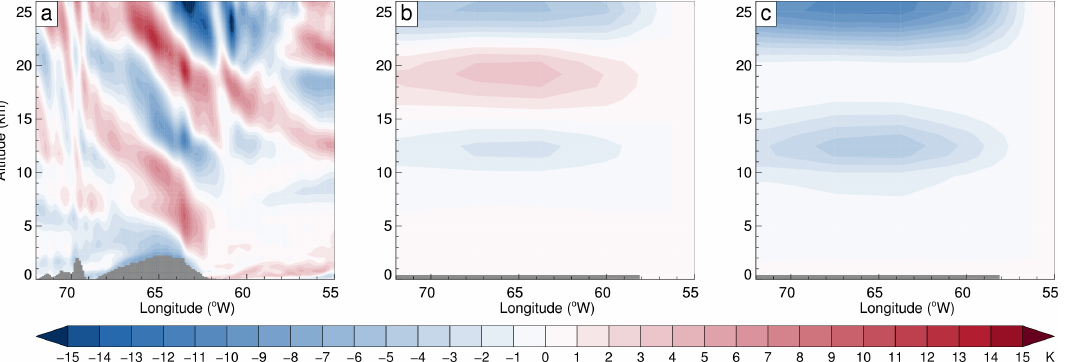
Figure 6. Vertical cross section intersecting the AP along a latitude band at 70 ◦ S of the temperature fluctuations (K) simulated by the mesoscale model (a) and parameterised by the mountain wave scheme (b) at the time of the CS3 mountain wave event. See Table 1 for dates. The grey shading indicates the height of the explicitly resolved orography. Also shown is the cooling phase of the parameterised temperature fluctuations (cid:49)T − (c) , i.e. the field which is actually coupled to the PSC scheme of the chemistry–climate SSO